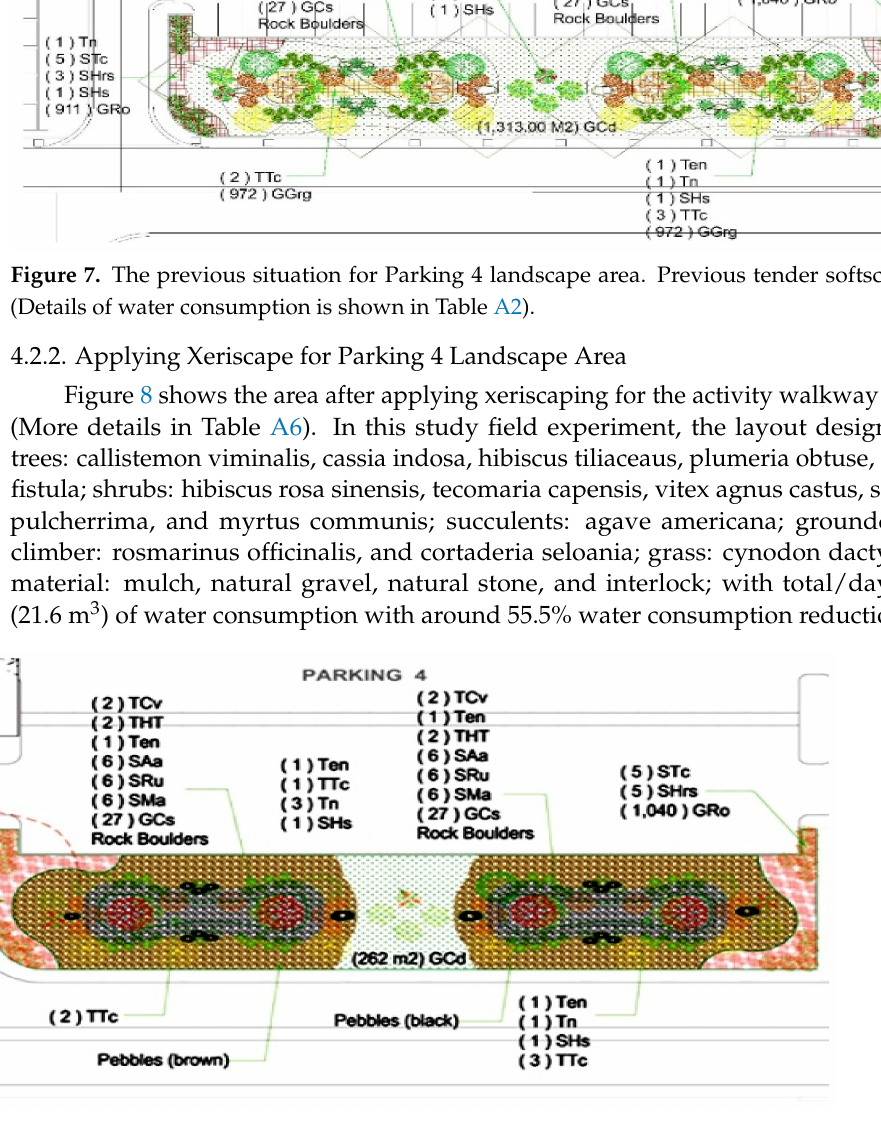
Figure 8. Applying xeriscape for Parking 4 landscape area. Xeriscaping softscape design (Details of water consumption is shown in Table